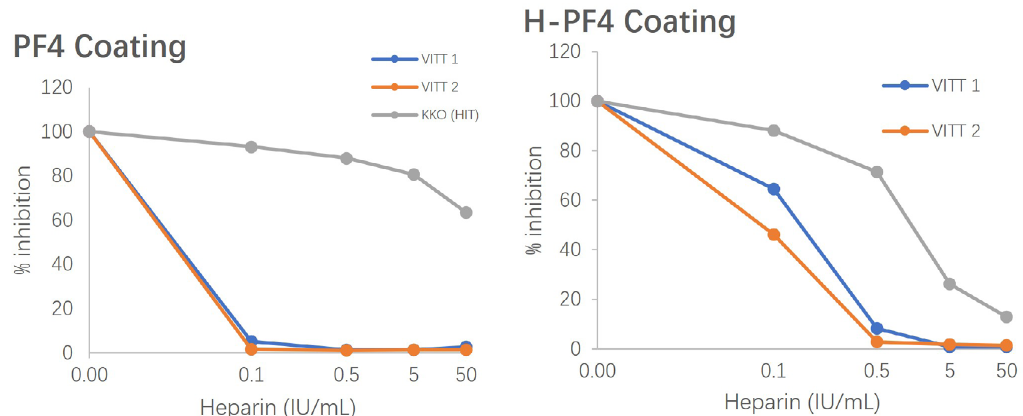
Figure 3. Inhibition of VITT antibodies binding to PF4 or H-PF4 coated plates tested by ELISA, comparatively to the HIT mimicking antibody (KKO); much lower concentrations of heparin totally inhibit binding to PF4, and a lesser extent to H-PF4 in VITT than in